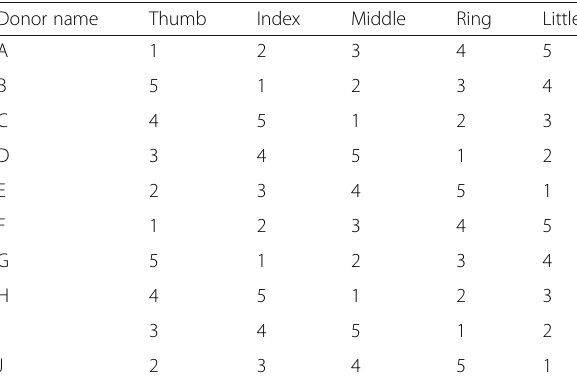
Table 3 Sample classification method using different extraction